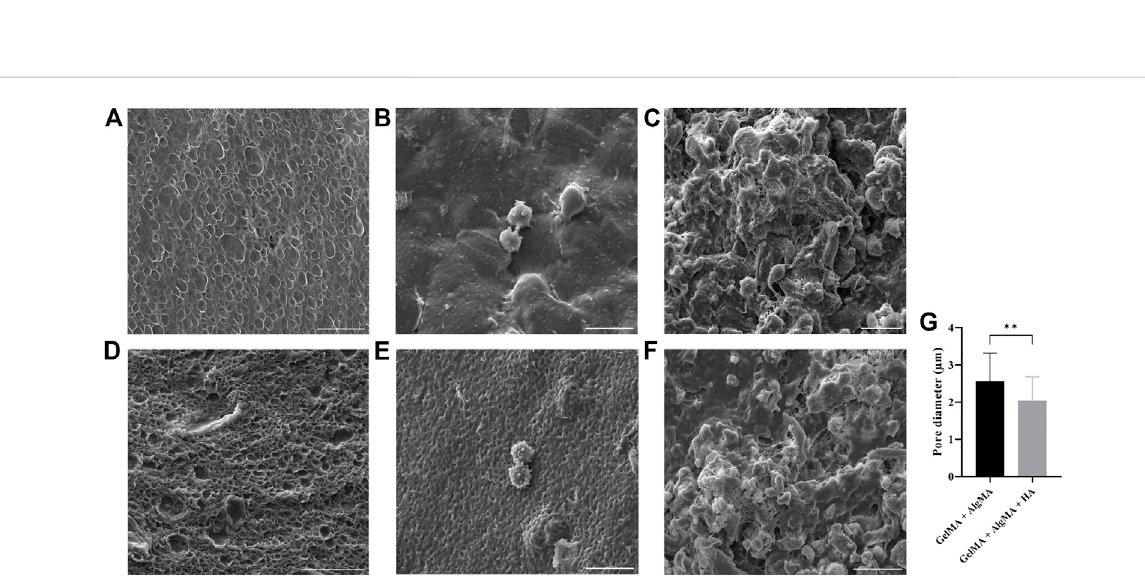
day 15, the results were identical to those of the control formulation, with increased cells, visible aggregates, and rearrangement of the scaffold (Figure 3F).